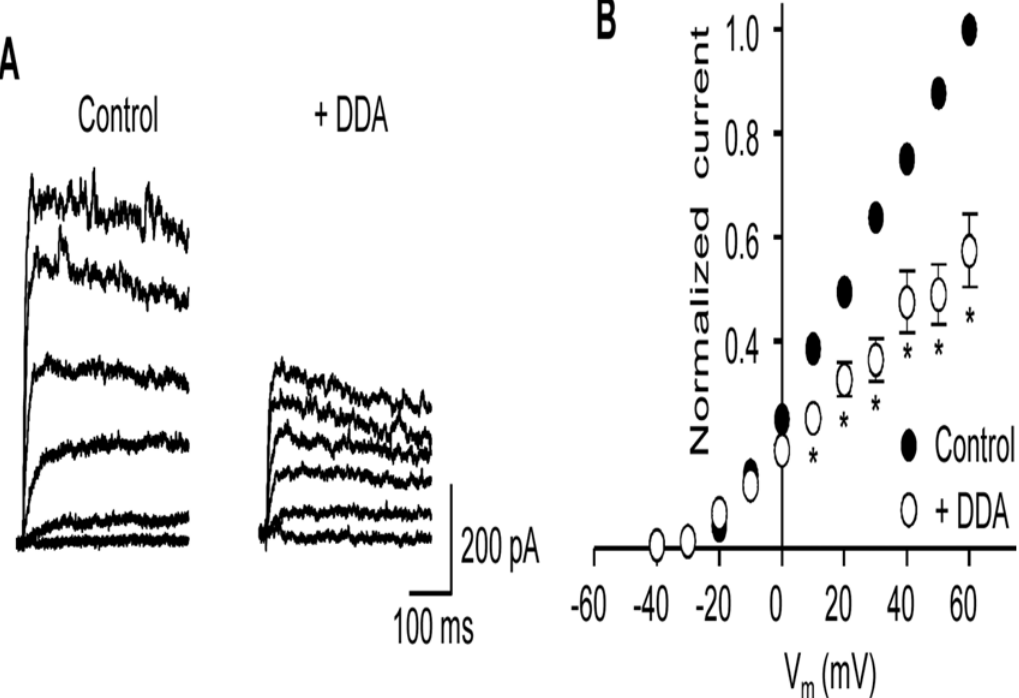
Fig 2. The adenlylate cyclase inhibitor, dideoxyadenosine attenuates K v current. ( A ) Representative K v current traces before (control) and after application of 50 μ M 2 ’ ,5 ’ -dideoxyadenosine (DDA). ( B ) Mean ( ± s.e.m.) I-V plots (normalized to control current at +60 mV) before (control) and after application of DDA. * P < 0.05; two-way ANOVA, Bonferroni ’ s post hoc